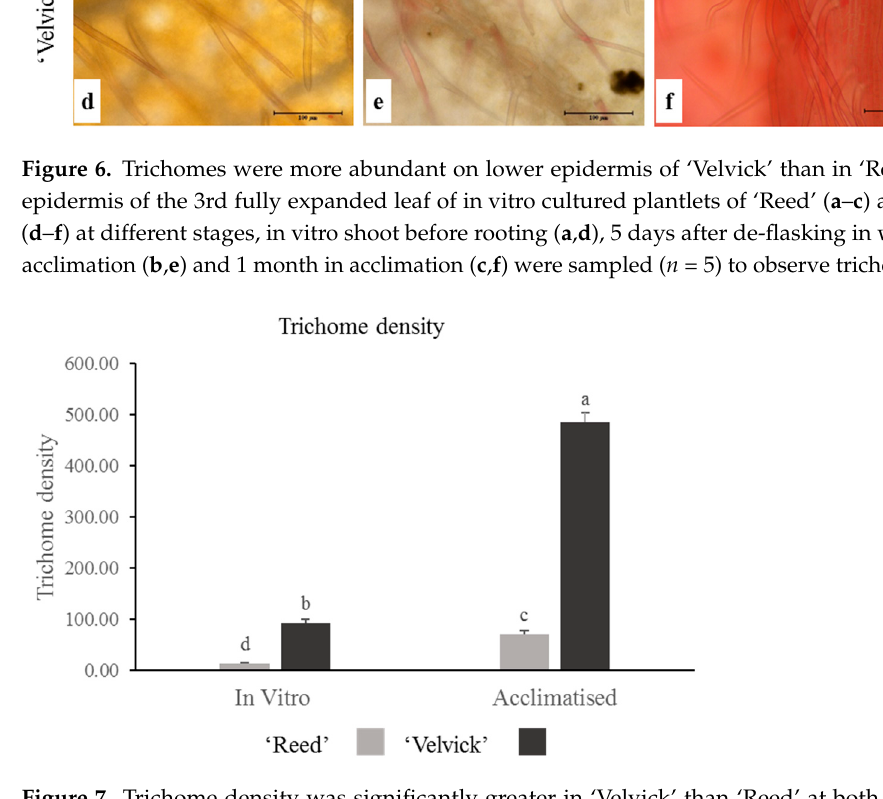
Figure 7. Trichome density was significantly greater in ‘Velvick’ than ‘Reed’ at both in vitro and acclimation. Both the rootstocks increased the trichome density from in vitro to acclimation stage. The letters a, b, c, and d indicate significantly different values within a tested stage between two rootstocks and between the two stages (in vitro and acclimated) at confidence level p = 0.05, n = 10 with two replicates and error bars indicate standard error.